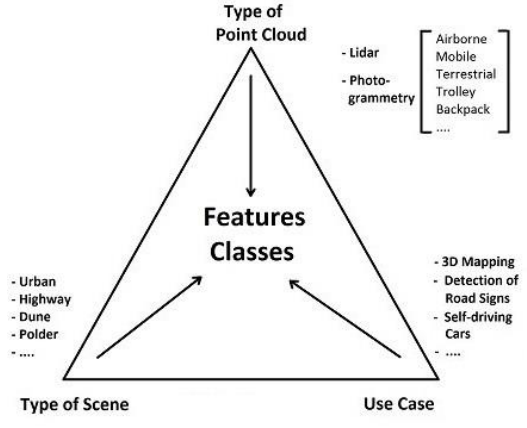
Figure 1. Dependence of features and classes on data